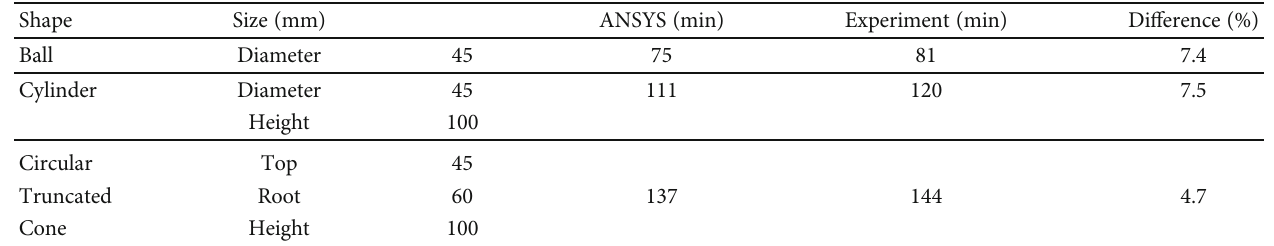
Table 3: The comparison of melting time between ANSYS simulation and experimental